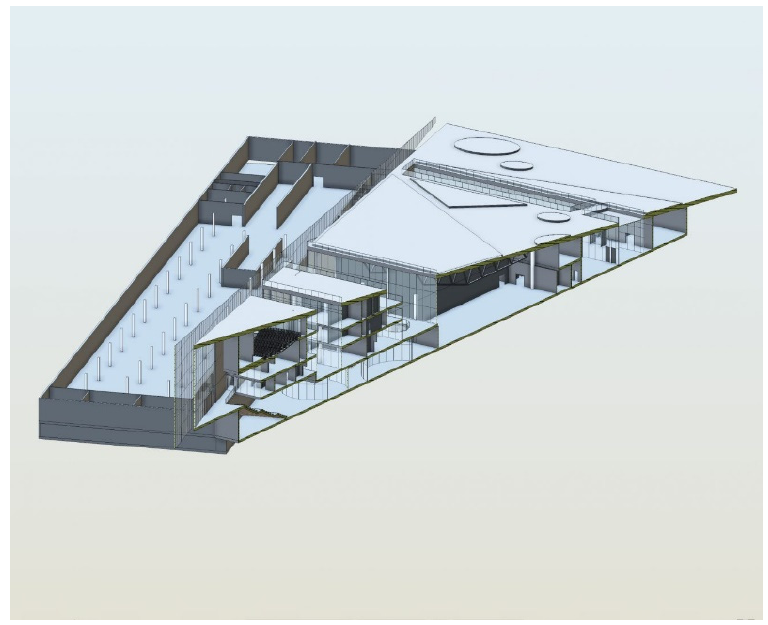
Figure 3. BIM model of the Cogiteon Lesser Poland Science Center. Source: [45].